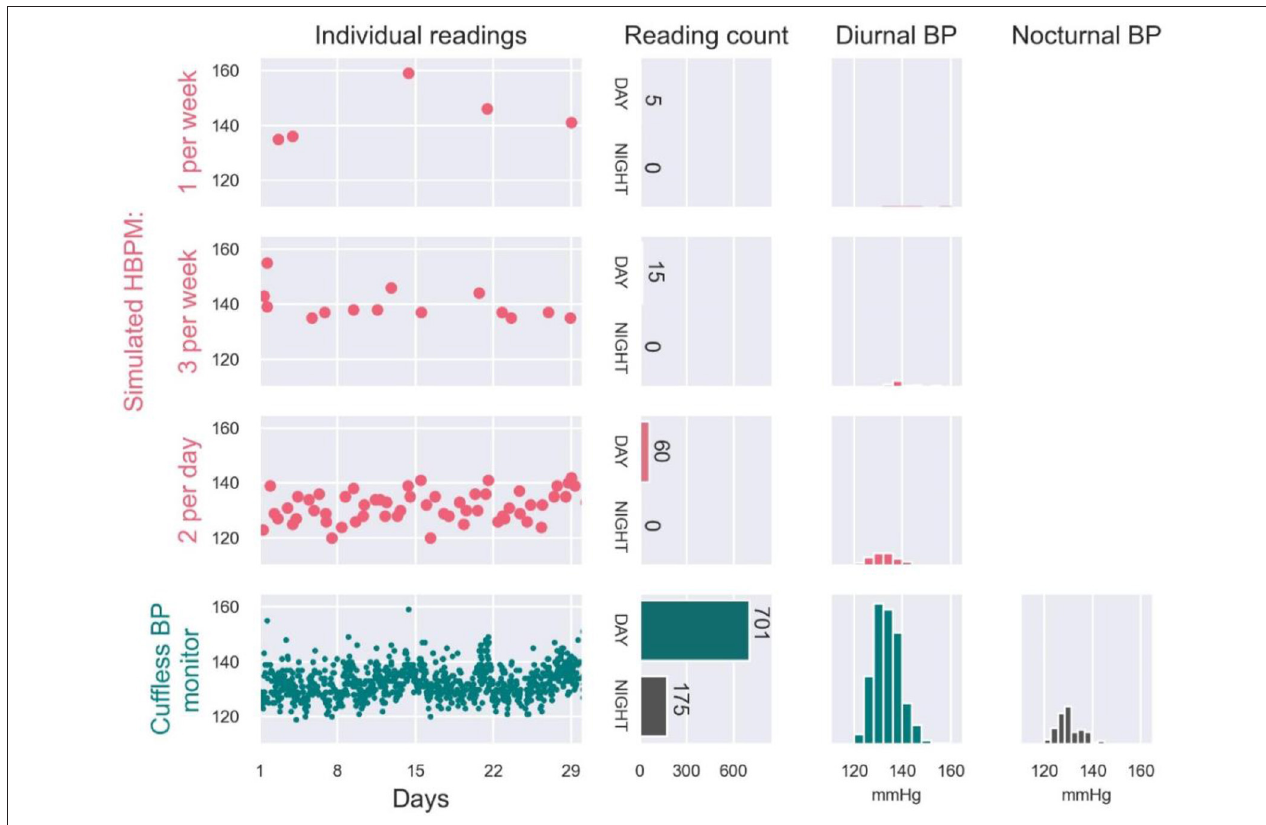
FIGURE 4 | Real-world SBP data collected on a patient by a continual cuffless BP monitor over one month (bottom panel, green), and simulated examples of HBPM readings that would have been recorded by the patient when performing 1 measurement per week (first panel, pink), 3 measurements per week (second panel, pink) and 2 measurements per day (third panel, pink). Simulated examples were generated by randomly resampling the measured continual BP